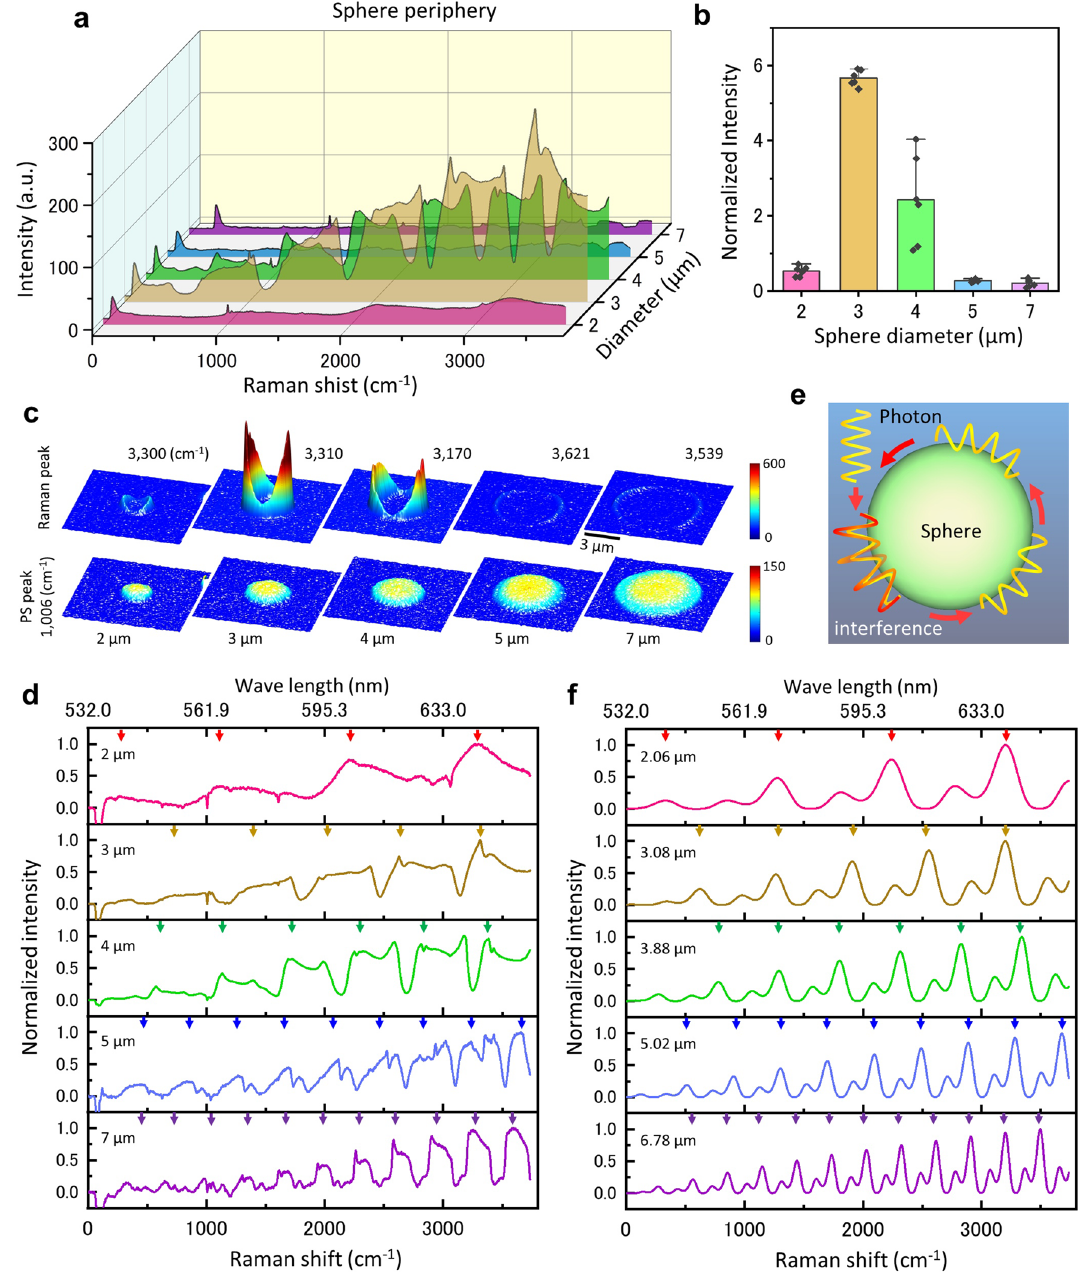
Figure 5. Sphere size and circulating light intensity. ( a ) Averaged Raman spectra of the circumference of PS spheres of 2–7 μm diameter on a 50 nm thick SiN film. ( b ) Relationship between the anomalous Raman peaks and sphere diameter. Six spheres were measured at each diameter and the ratio of the maximal anomalous Raman intensity to the PS peak (1006 cm −1 ) at the sphere centre was calculated and normalised. The mean values of normalized intensity from 2 to 7 μm diameter are 0.527, 5.66, 2.43, 0.274 and 0.207 respectively. Standard deviations are 0.137, 0.213, 1.196, 0.032 and 0.099. The anomalous Raman peak intensity was the highest at the sphere diameter of 3 μm but was very low at 2 μm and 5–7 μm. ( c ) Pseudo-3D colour maps of the PS peak and the circumferential peak for sphere diameter of 2–7 μm. The maps of the PS peak show similar dome-like shape for all diameters (bottom row). With the anomalous Raman peak, the ring shape around the spheres was clearly observed at the SiN thickness of 3 and 4 μm (top row). ( d ) Normalized Raman spectrum of the sphere circumference with a diameter of 2–7 μm. The arrows in the figure indicate the peaks of each spectral periodicity. With the sphere diameter increment from 2 to 7 μm, the periodicity of the Raman spectrum increases from 4 to 11. ( e ) Schematic of the interference produced by light circulating around the sphere. A photon travelling around the periphery of the sphere interferes with other photons while they travel around the sphere. ( f ) Raman spectrum of sphere periphery by the numerical model of Eq. (1). The sphere diameters of the model were set to the values where the period and phase were in close correspondence with the experimental results (left side diameters in each plot). Scale bar, 3 μm in ( c